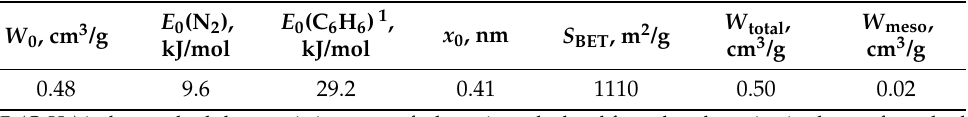
Table 1. The porous structure parameters of the SiC-AC adsorbent calculated from the isotherm of nitrogen vapor adsorption/desorption at 77 K by the D-R, Brunauer–Emmet–Teller (BET), and Kelvin [47]